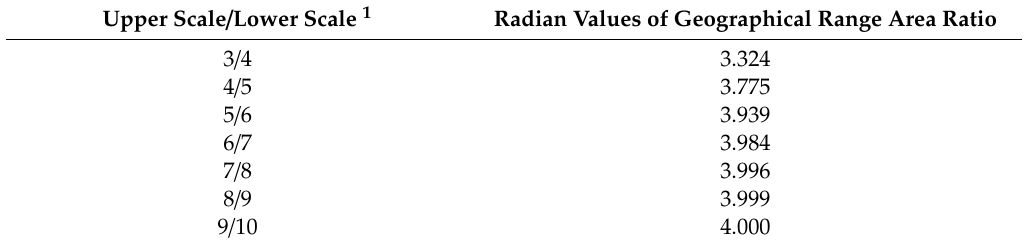
Table 2. Table of radian values of geographical range area ratio.